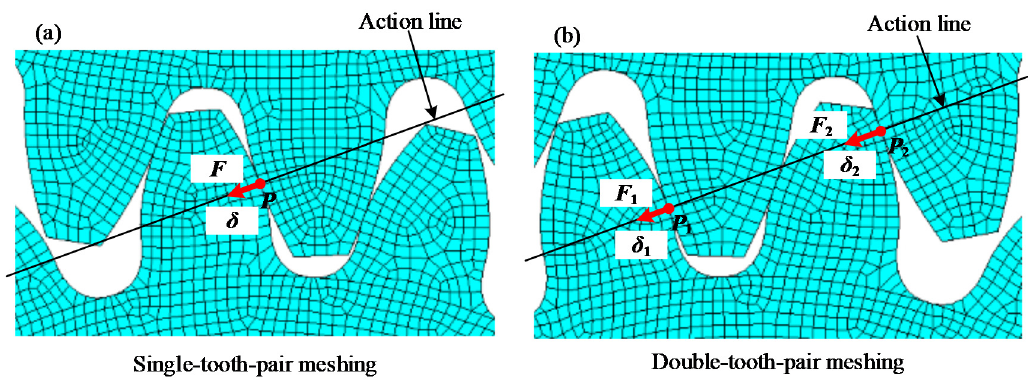
Figure 2. Gear meshing scenarios.